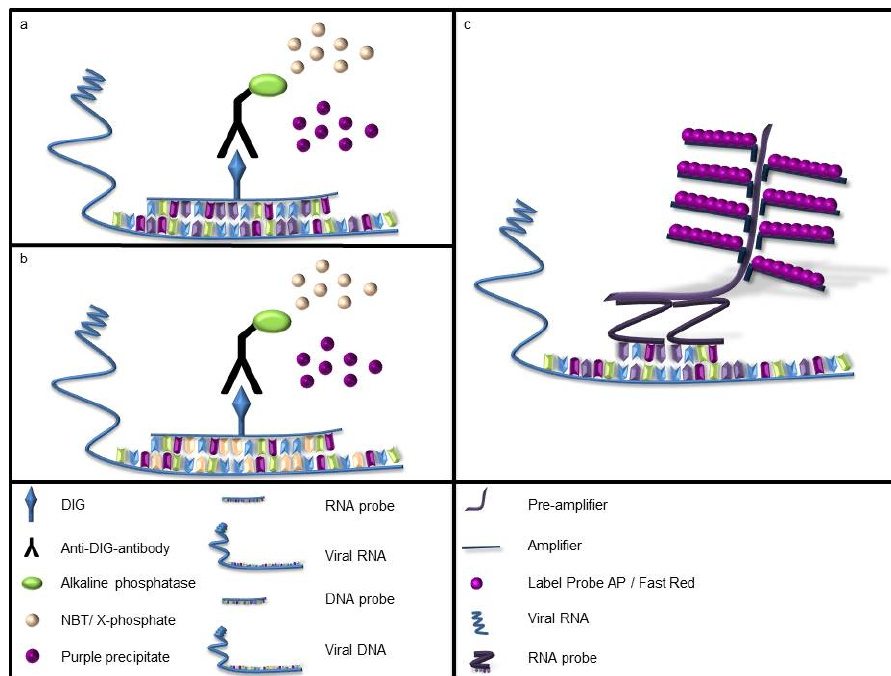
Figure 1. Overview of the different in situ hybridization techniques. ( a ) Self ‐ designed digoxigenin (DIG) ‐ labelled RNA and ( b ) commercially produced DIG ‐ labelled DNA probes of varying length are able to detect viral nucleic acids. The observed signal is achieved by reaction of the probe with the targets of interest and visualized using an alkaline phosphatase labelled anti ‐ DIG ‐ antibody. The enzyme catalyzes the reaction of the substrates nitroblue tetrazoliumchloride and 5 ‐ bromo ‐ 4 ‐ chloro ‐ 3 ‐ indolyl phosphate to a purple precipitate; ( c ) Hybridization of two probes of the fluorescent in situ hybridization (FISH) ‐ RNA probe mix to adjacent regions of the viral sequence to be detected allows further amplification steps, including the pre ‐ amplifier, the amplifier and the alkaline phosphatase (AP) labelled probe reaction. Following an AP ‐ enhancement, addition of the substrate Fast Red results in a red precipitate in the tissue which can be evaluated using light as well as fluorescence microscopy.